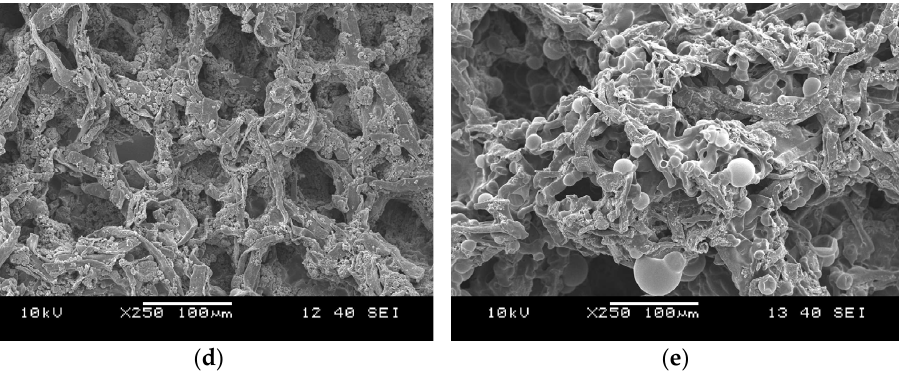
Figure 7. SEM images of the charred residues of; ( a ) PLA + MPP, ( b ) PLA + MPP + C60, ( c ) PLA + MPP + FR-C60, ( d ) PLA + MPP + C300, ( e ) PLA + MPP + FR-C300.